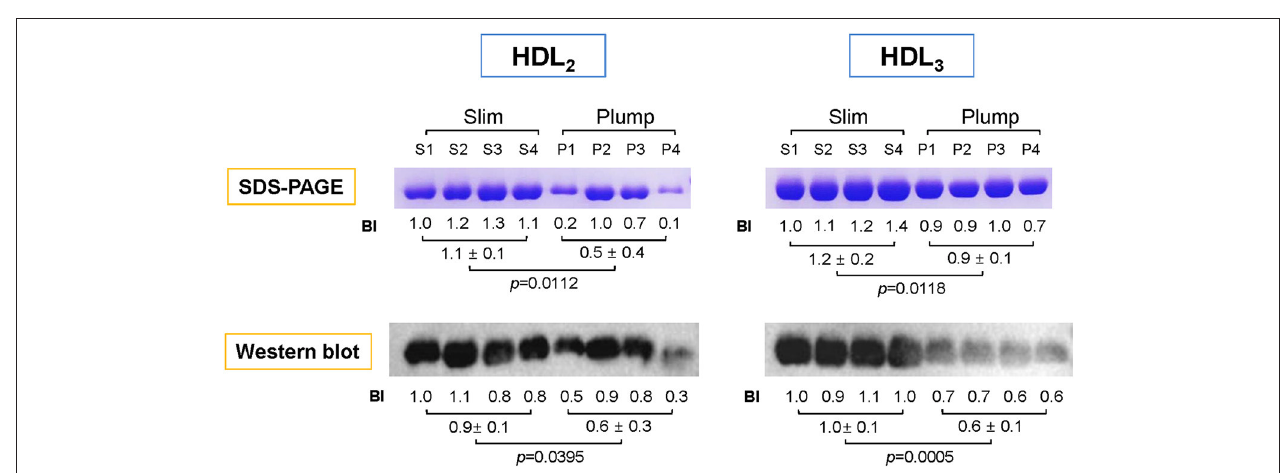
FIGURE 2 | Electrophoretic patterns of apolipoproteins in HDL 2 and HDL 3 . The number indicates band intensity (BI) of apoA-I from densitometric analysis using Gel-Doc (Bio-Rad). The expression level of apoA-I was compared by Western blotting. BI was calculated using Chemi-Doc